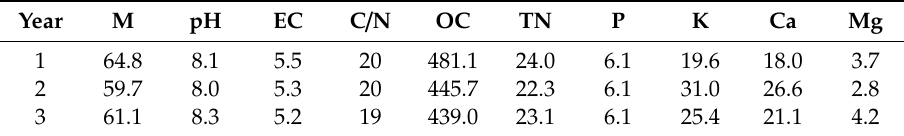
Table 2. Chemical analysis of the sheep manure (LSM), nutrients, given on a dry matter basis.